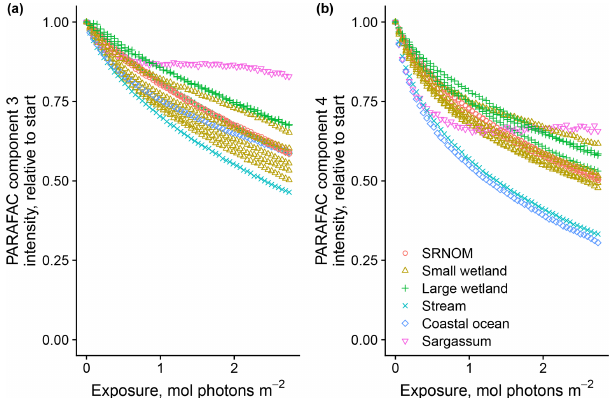
Figure 8. Photodegradation time series of PARAFAC components three (a) and four (b) fluorescence intensity, relative to starting val- ues. Data are shown from experiments using PPL extracts from dif- ferent DOM sources (see Sect. 3.1 for source descriptions). Large wetland and small wetland samples use the same symbol for sam- ples from each source, including samples collected on different